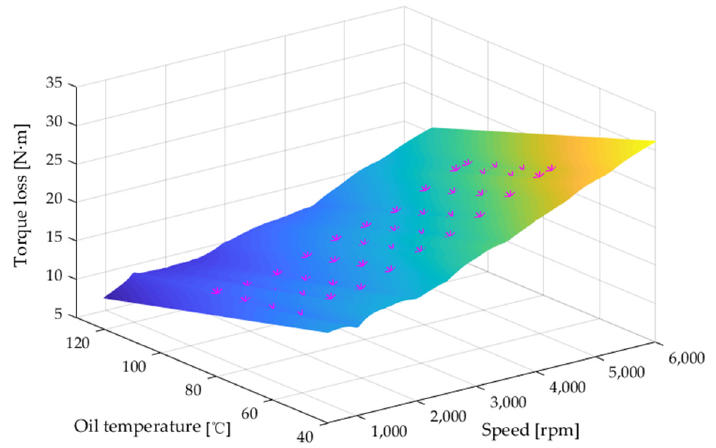
Figure 8. The engine thermal efficiency correction